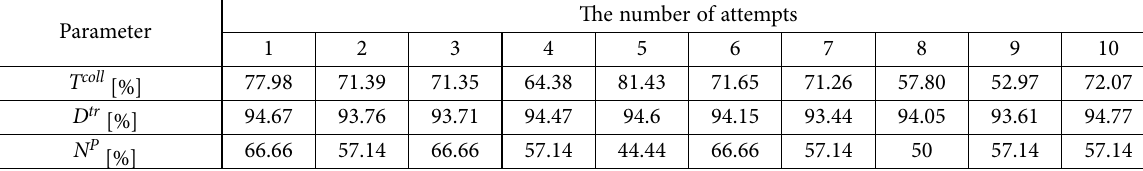
Table 4. Assignment performance